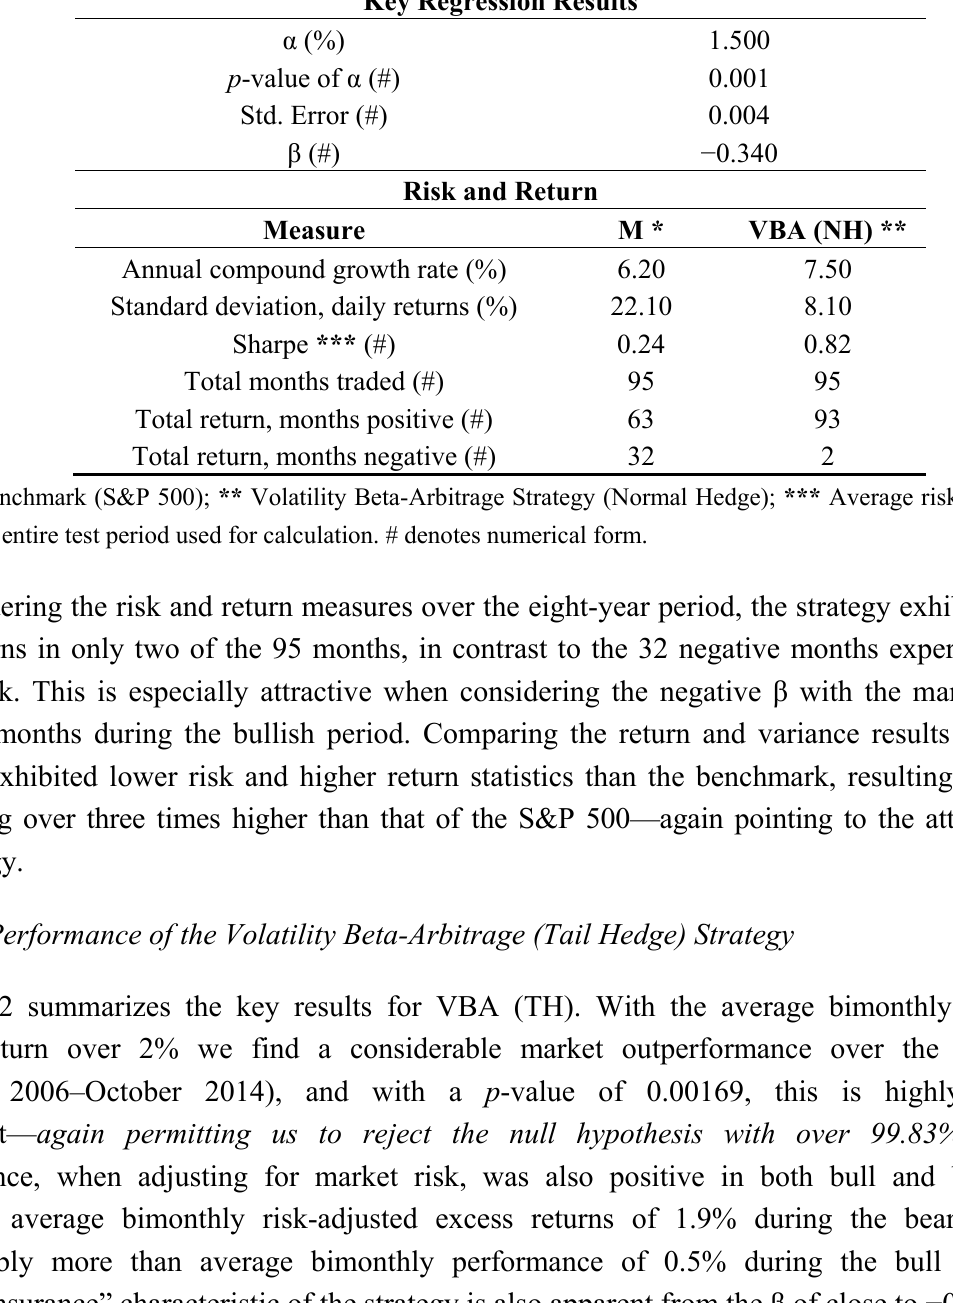
Table 1. Bimonthly Performance of Volatility Beta-Arbitrage—Normal Hedge (October 2006–October 2014). Key Regression